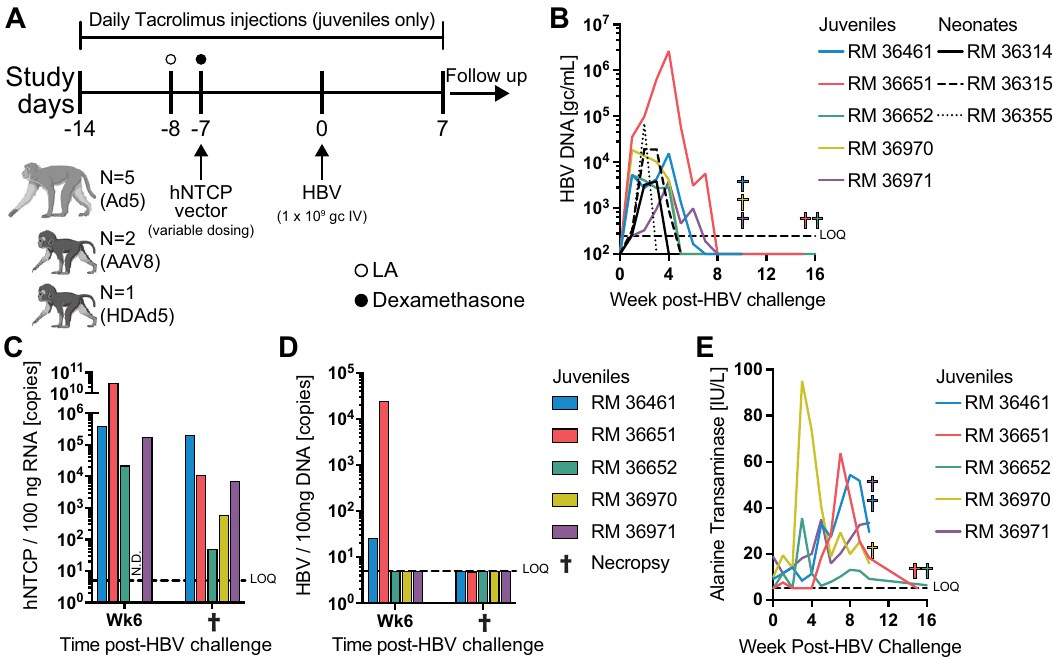
Fig. 1 Transient HBV infection in RM. A Timeline for HBV infection of RM. B sVL in juvenile and infant RM. C Liver hNTCP RNA quanti fi cation by RT-qPCR. D Liver HBV DNA quanti fi cation by qPCR. E Serum ALT concentrations. Macaque clip art created with BioRender.com. Source data are provided as a Source Data fi le.